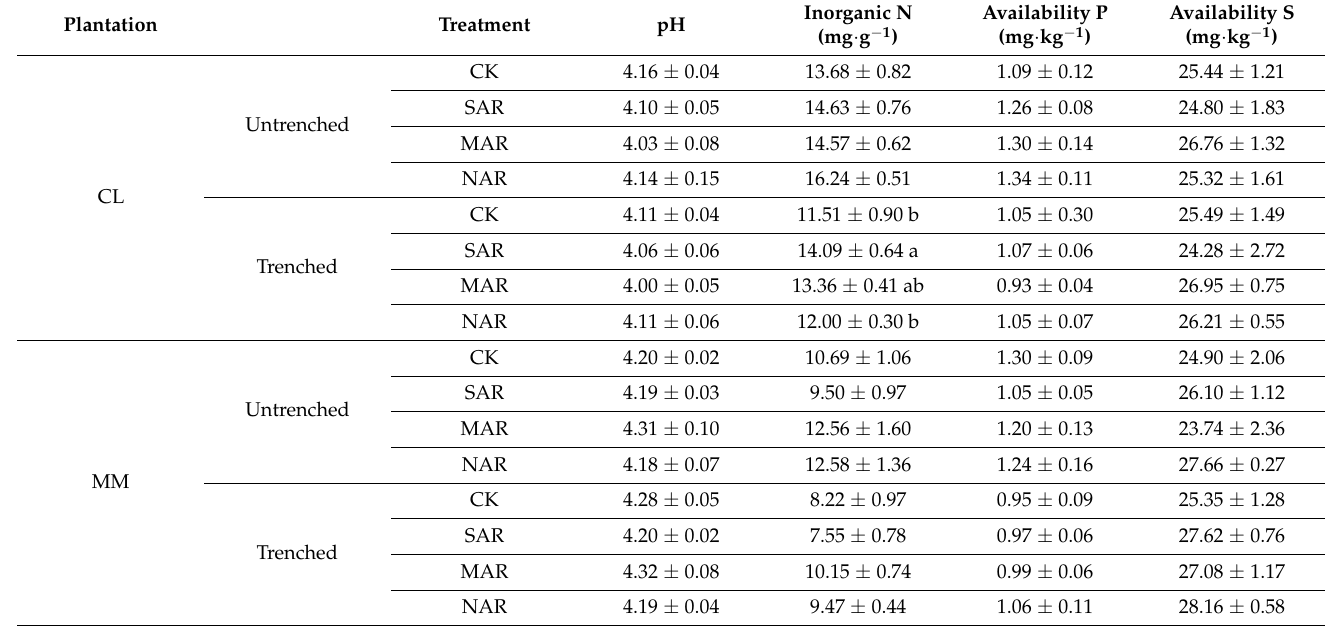
Table 2. Variations in soil properties under different types of acid rain in Cunninghamia lanceolata (Lamb.) Hook. (CL) and Michelia macclurei Dandy (MM) plantations. Data are the mean ± standard error ( n = 4). Means with different letters in common are significantly different ( p < 0.05). The absence of letters indicates no significant differences among acid rain treatments.